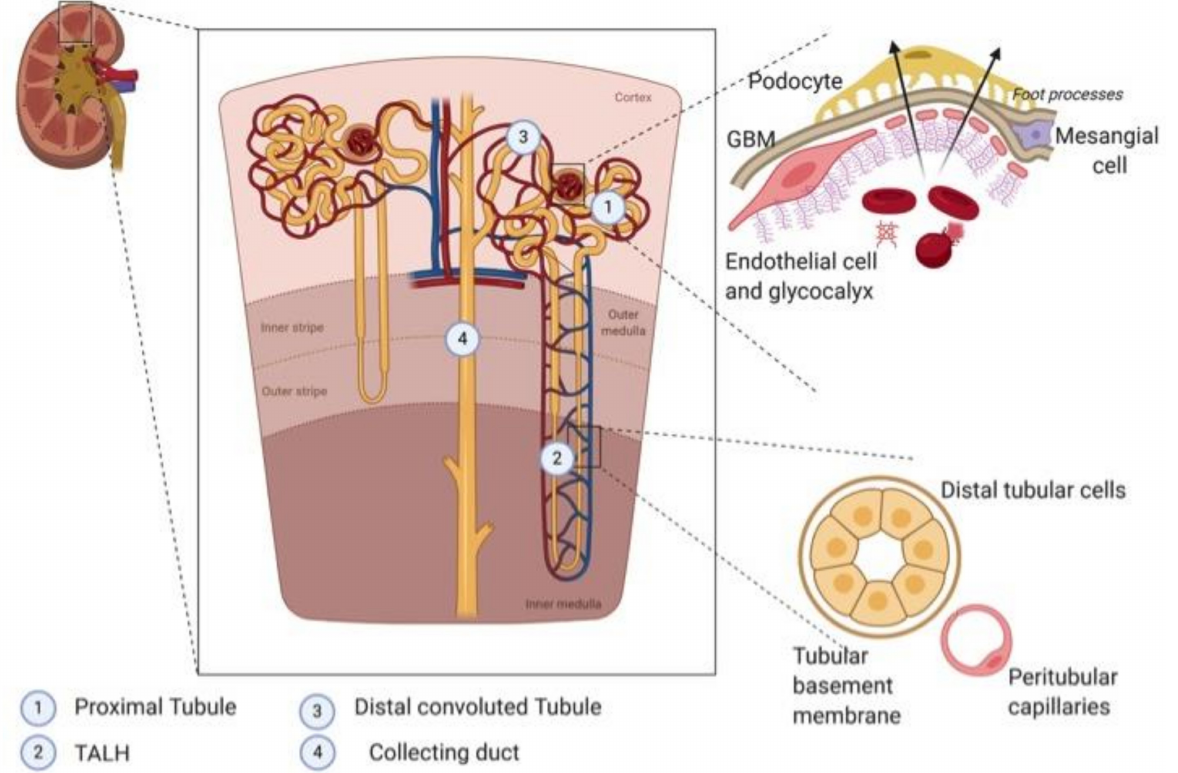
Figure 1. Schematic view of kidney structures describing cortical and medullar compartments, components of glomerular basement membrane and tubular segments and structures. GBM: Glomerular basement membrane, TALH: Thick ascending loop of Henle (Created with